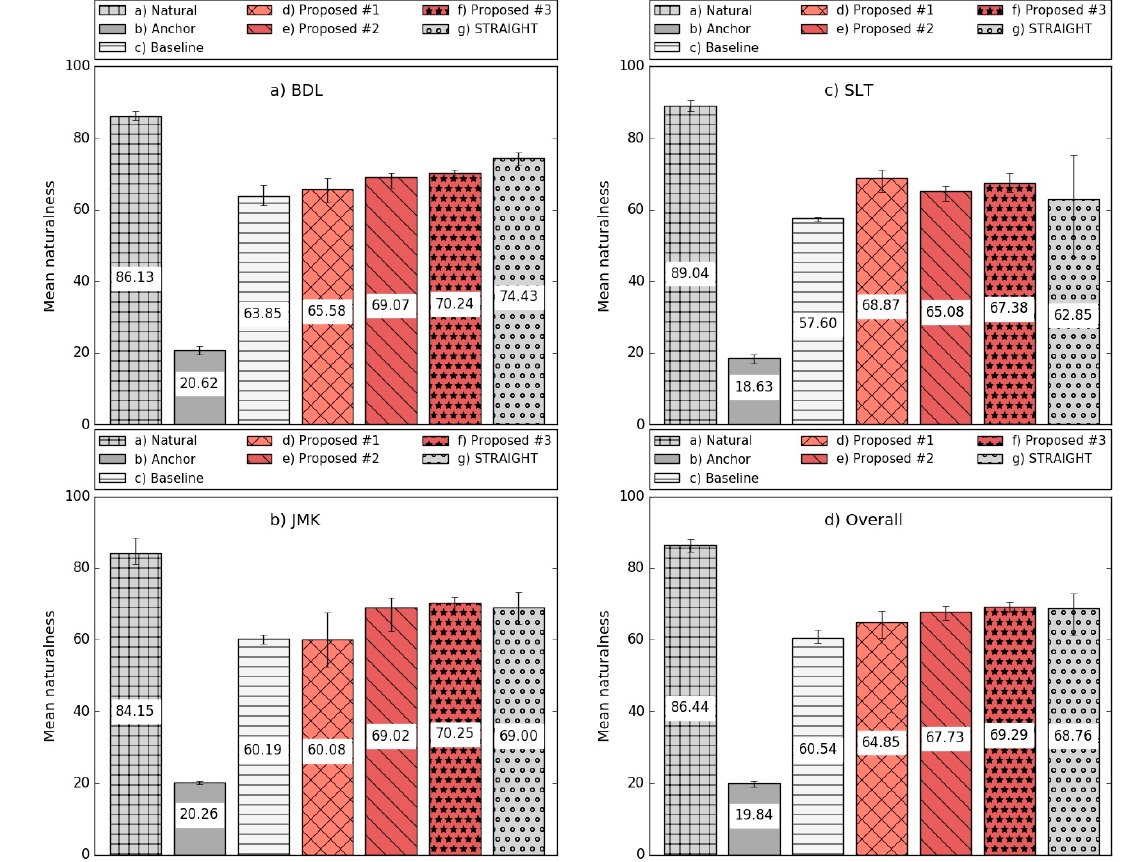
Figure 10. Results of the subjective evaluation for the naturalness question. A higher value means greater naturalness. Error bars show the bootstrapped 95% confidence intervals.